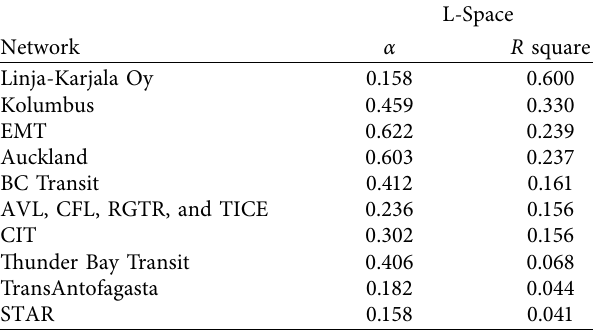
Table 2: Fitting in L-Space of the network degree distribution to a power law function P ( k ) ∼ k − α